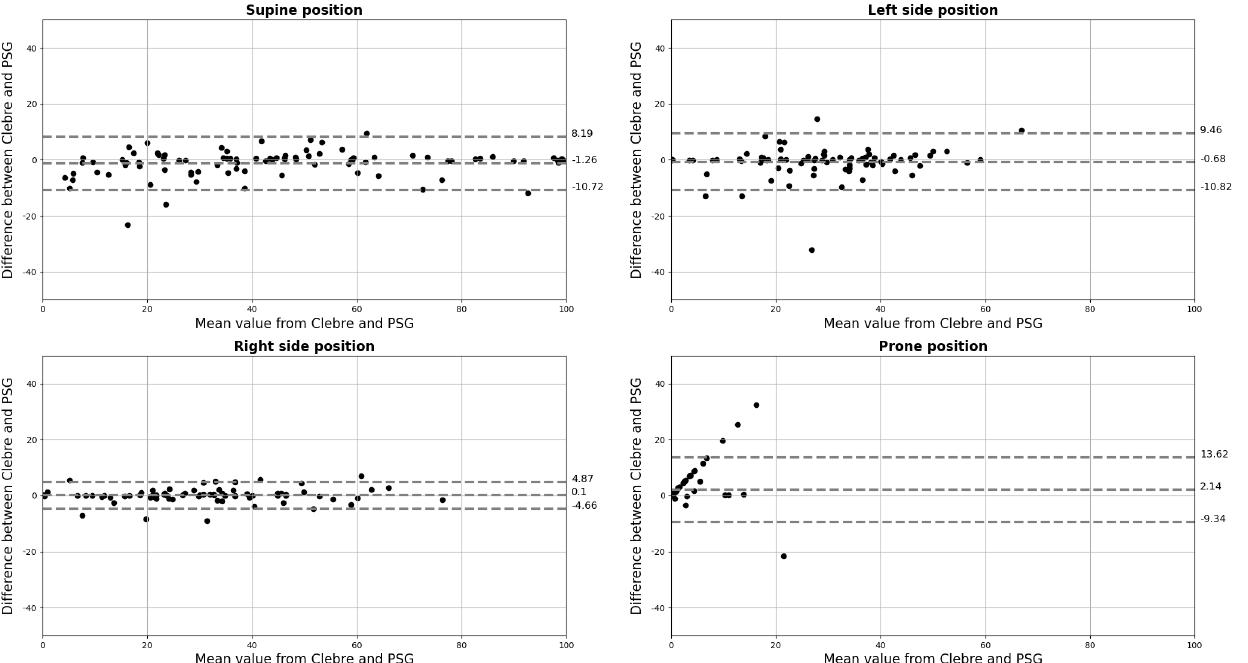
Figure 4. The Bland–Altman plots for percentages of each lying body position in relation to sleep time; percentages on both